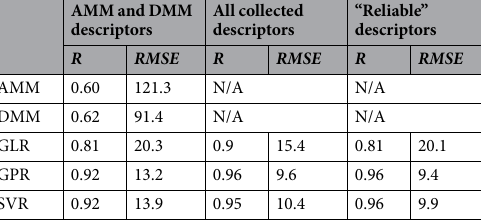
Table 1. Comparison of R and RMSE predicted by different models using different sets of